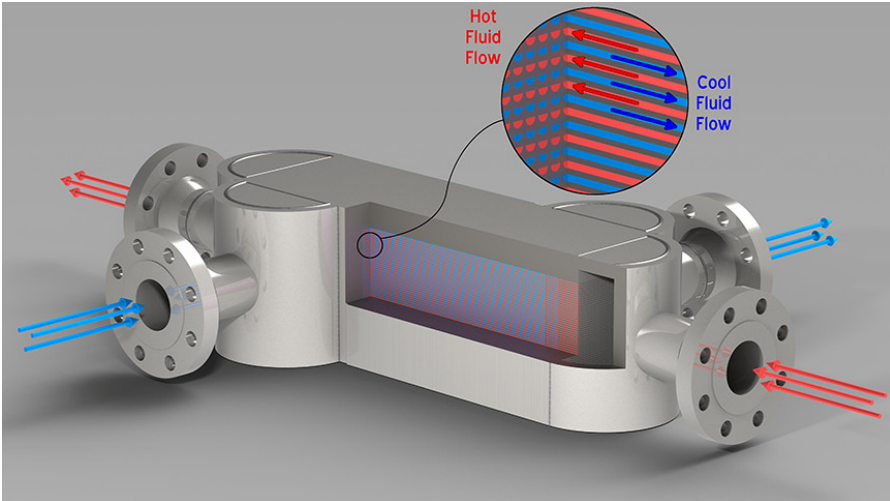
Figure 7. Diffusion-bonded microchannel heat exchanger [80] .